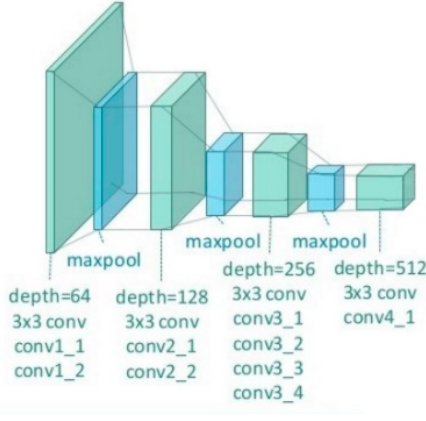
Figure 3. The structure of VGG-19.